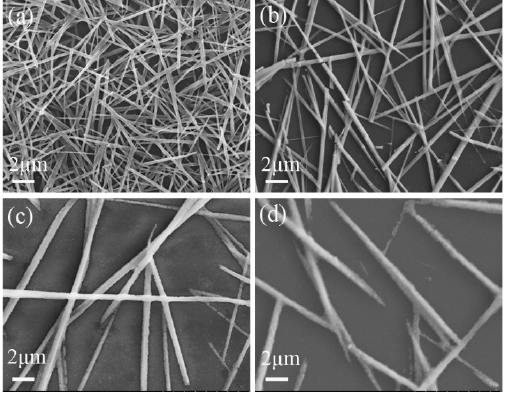
Figure 3. SEM (Transmission electron microscopy images) of perovskite nanowires synthesized with different PbI 2 precursor concentration of ( a ) 0.5 M; ( b ) 0.4 M; ( c ) 0.3 M and ( d ) 0.2 M.